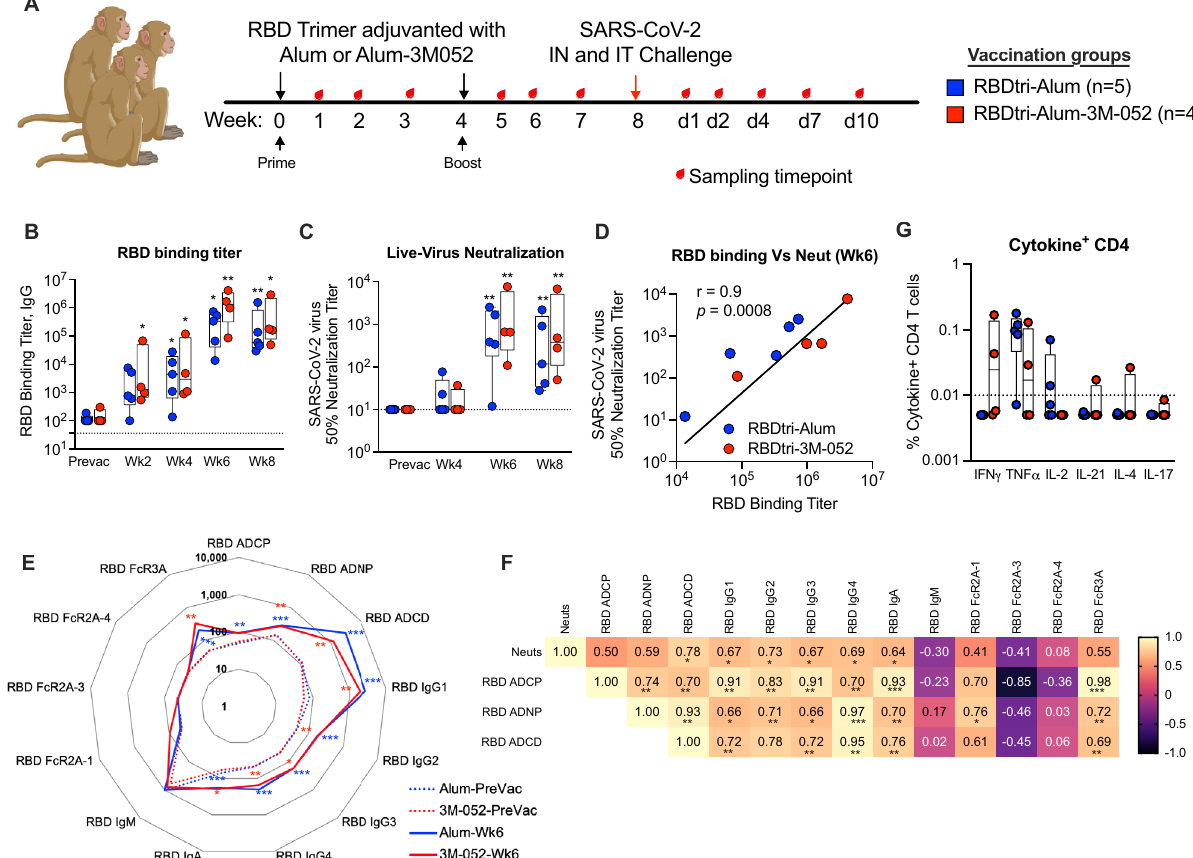
Fig. 3 RBD trimer induces both neutralizing and non-neutralizing antibodies with effector function in macaques. A Schematic showing timeline of RBD trimer vaccination, SARS-CoV-2 challenge, and sample collection for the macaque study. Rhesus macaques ( n = 9) were distributed into two experimental groups to immunize with RBD trimer (30 µ g/dose) adjuvanted either with alum (blue) ( n = 5) or with alum-3M-052 (red) ( n = 4) via intramuscular route at weeks 0 and 4. Seven unvaccinated animals served as controls. Vaccinated and control animals were challenged intranasally (IN) and intratracheally (IT) with SARS-CoV-2 at 4 weeks following boost. B Endpoint IgG titers against SARS-CoV-2 RBD measured in serum collected before vaccination (Prevac) and at weeks 2, 4, 6, and 8 after priming immunization. Each sample was analyzed in duplicates and repeated twice. C Neutralization titer against live mNeonGreen SARS-CoV-2 virus in serum. Each sample was analyzed in duplicates and repeated twice. D Correlation analysis between SARS-CoV-2 neutralization titer and RBD binding titers. The Spearman rank test was used to perform correlation analysis. Dotted lines re fl ect the limit of detection. E Radar plot showing SARS-CoV-2 RBD-speci fi c systems serology measurements (antibody isotypes and subclass, Fc γ R binding, and antibody-dependent effector functions) at pre-vaccination and week 6 post-vaccination time points. F Correlation matrix analysis between antibody-dependent functions (neutralization, ADCP, ADNP, and ADCD) and SARS-CoV-2 RBD-speci fi c antibody isotypes, and Fc γ R binding at 2 weeks post the boost. The color refers to r value scale ( − 1 to 1) shown on the right. The number in each cell indicates the actual r value and the stars represent p -values. G IFN γ + , TNF α + , IL-2 + , IL-21 + , IL-4 + , and IL-17 + CD4 + T cells speci fi c to total S protein (sum of response to peptide pools S1 and S2) in blood at week 5 post boost. Box and whiskers (min to max) plot showing all the data points in each group. Individual animals were indicated with circles. p -values were calculated using a Mann – Whitney test, represent the difference between pre-vaccination and respective post-vaccination value. ∗ p < 0.05; ** p < 0.001; and *** p <